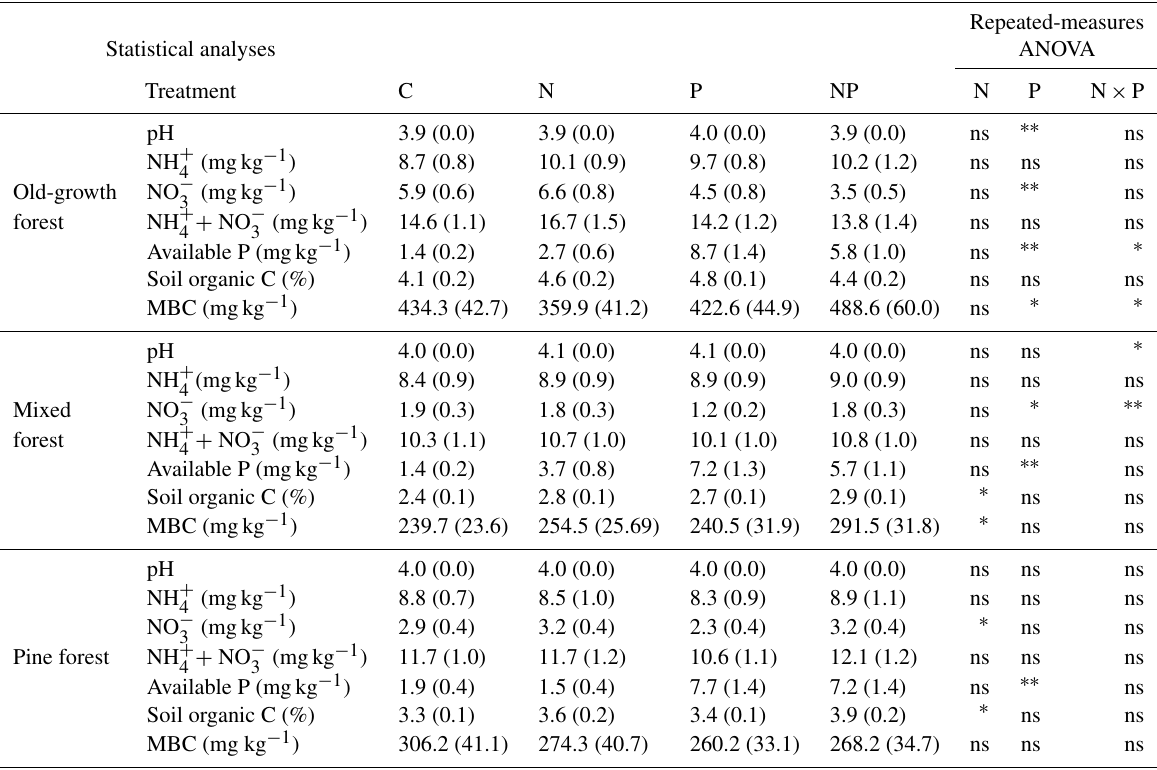
Table 2. Effects of N and P addition on soil properties in the three study forests.